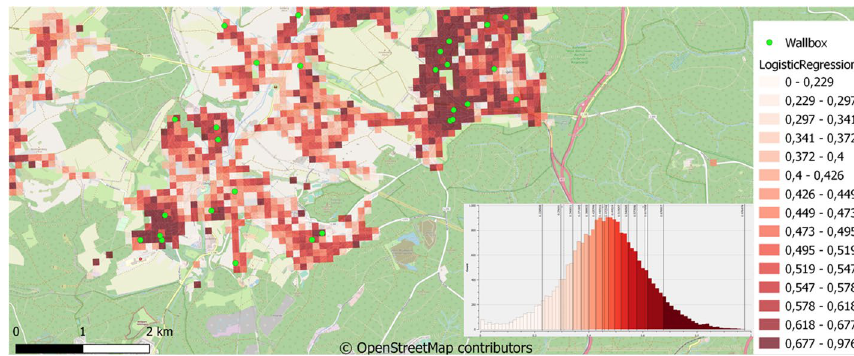
Fig. 4 Segment from the geographical depiction of the E-mob